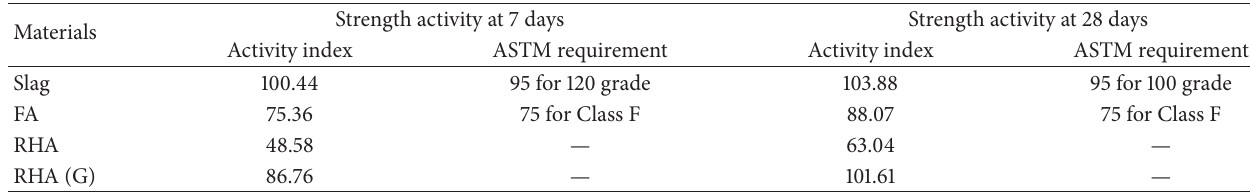
Table 3: Strength activity index of